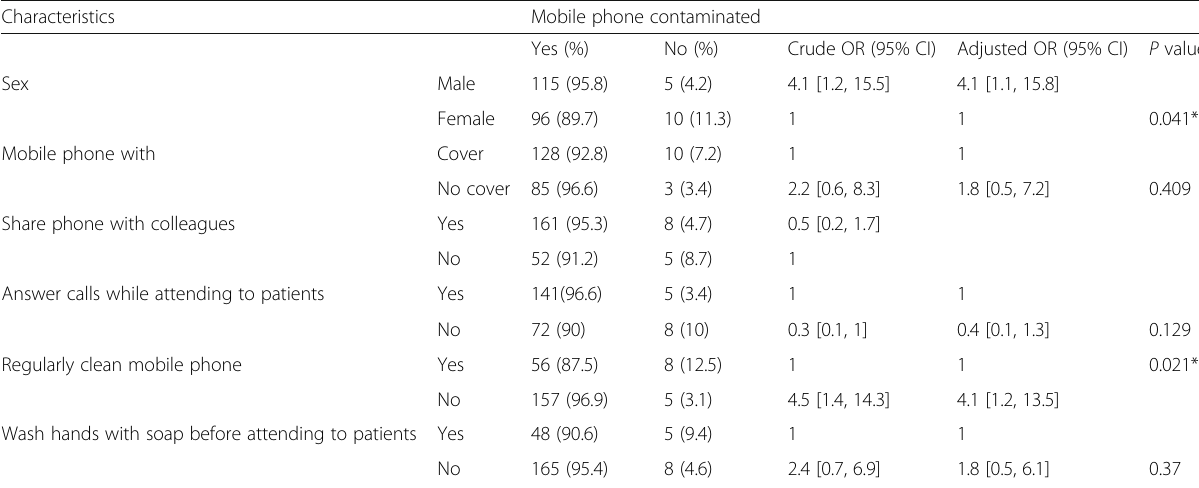
Table 3 Factors associated with mobile phone bacterial contamination amongst health professionals ( n = 226) at Hiwot Fana Specialized University Hospital, Harar, Eastern Ethiopia, Feb – Mar 2018 Characteristics